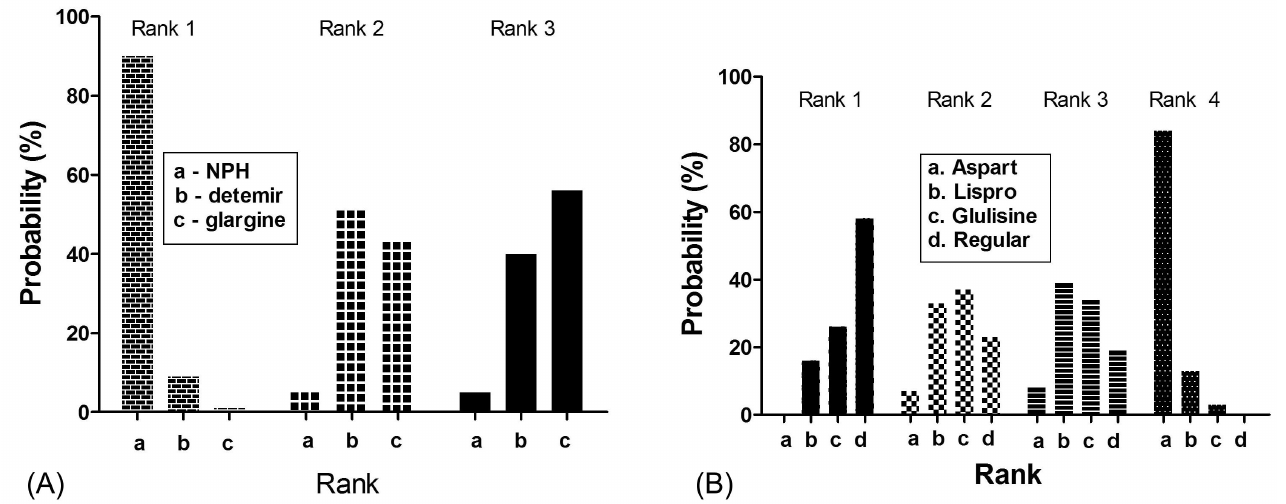
mellitus. Rank 1 represents the insulin analog most likely to be the first choice for treatment of type 1 diabetes